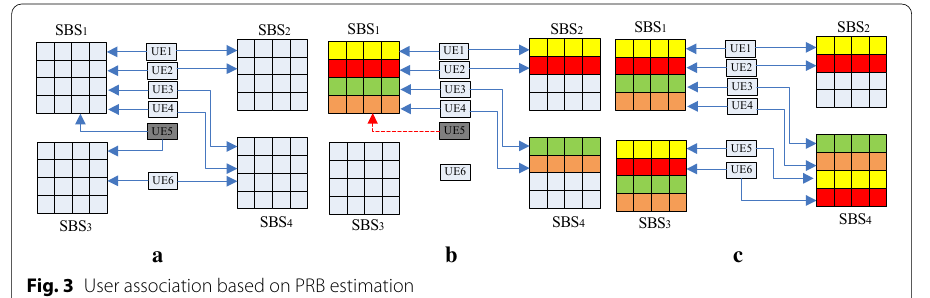
Fig. 3 User association based on PRB